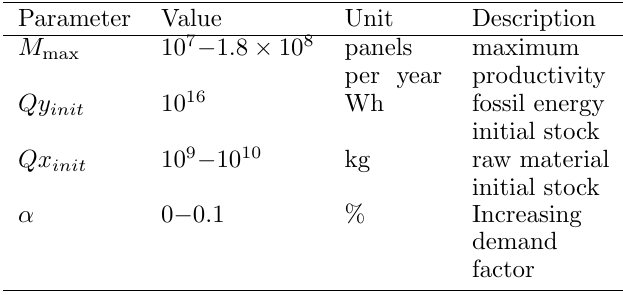
Table 3. Industrial parameters of the model.